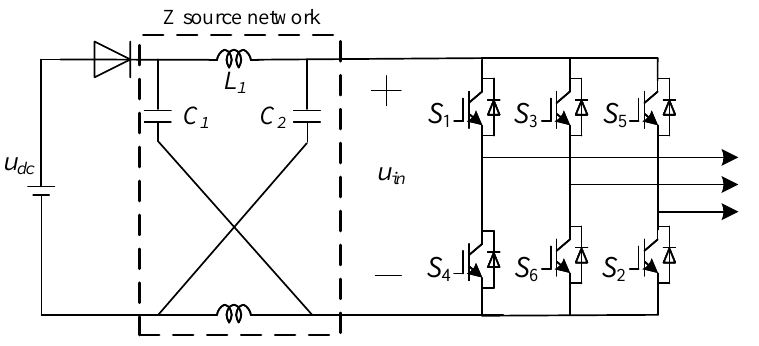
Figure 1. Z-source inverter